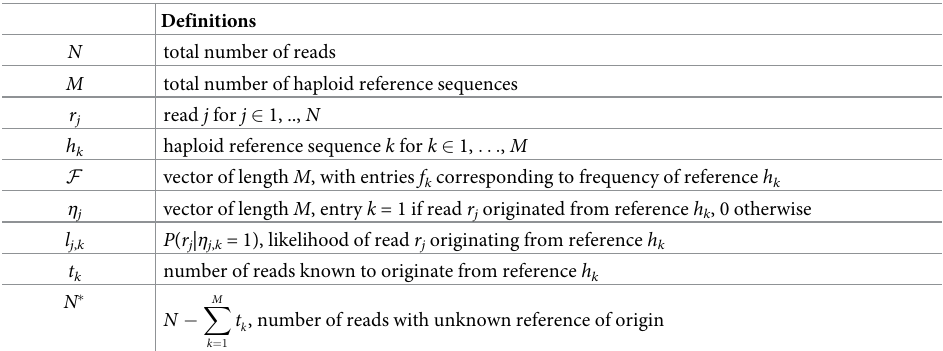
Table 1. Materials and methods